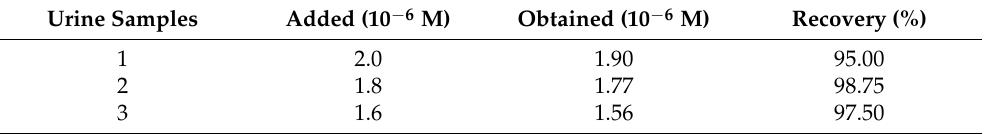
Table 4. Urine sample